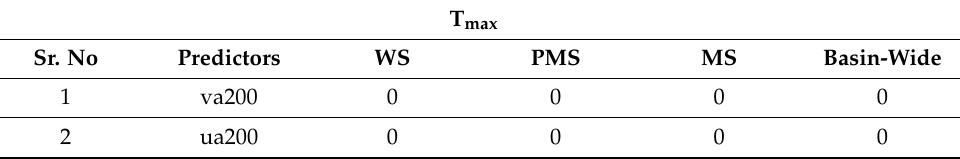
Table 1. Seasonal contributions of different predictors (in %) that helped to resolve observed tem- peratures (T max and T min ) over the Indus basin of Pakistan. Multiple linear regression models were used to identify these temperature-governing predictors. Column 2 provides the list of large-scale atmospheric predictors used in this study, where the symbols zg, va, ua, hur, hus, ta, and psl denote the geopotential heights, meridional winds, zonal winds, relative humidity, specific humidity, air temperature, and mean sea level pressure fields, respectively. The number after each predictor symbol reflects the atmospheric level (pressure level in hPa. The last column shows average predictor frequencies over all three